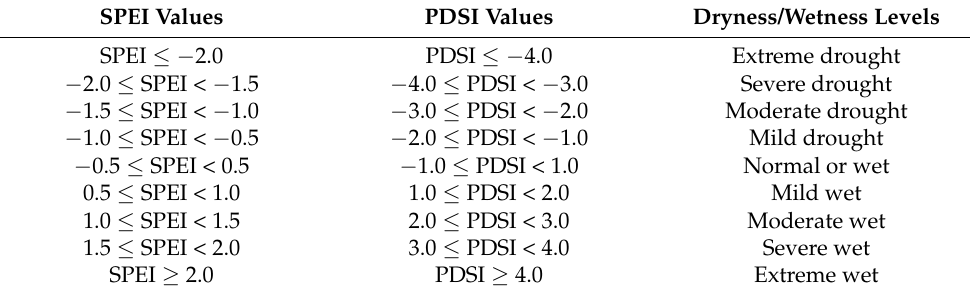
Table 2. Different levels of the SPEI and